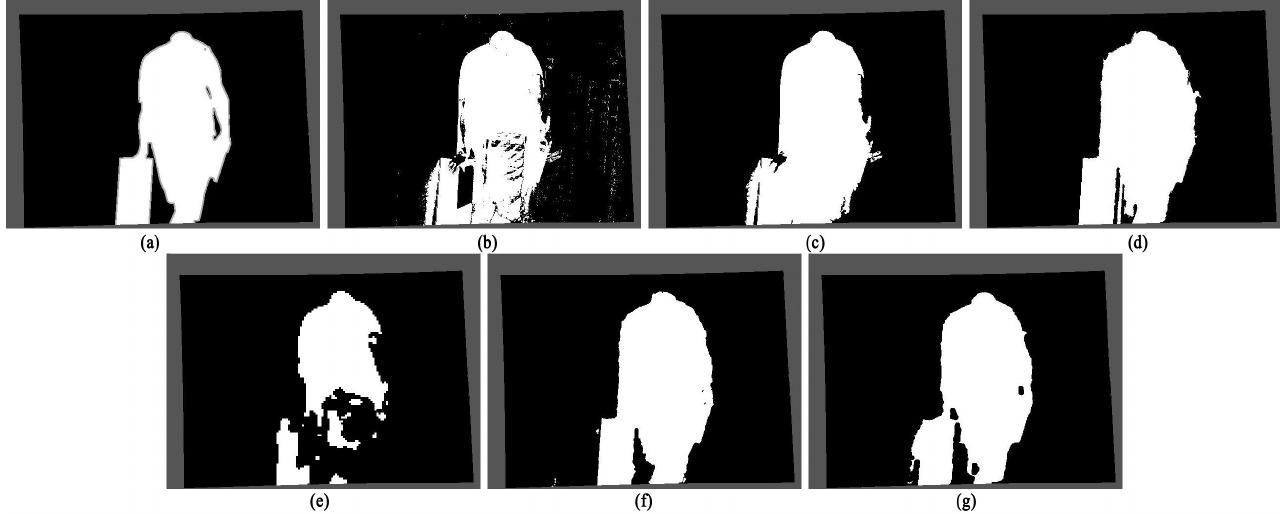
Figure 11. Comparison of the detection results of the two algorithms in Experimental Scenario Two: ( a ) Ground truth; ( b ) The detection result of the original codebook algorithm; ( c ) The detection result of the original codebook algorithm with noise points removed using morphological operations; ( d ) The detection result of the algorithm proposed in this article; ( e ) The detection result of the SRPCA method; ( f ) The detection result of the CwisarDH + method; ( g ) The detection result of the BSABU